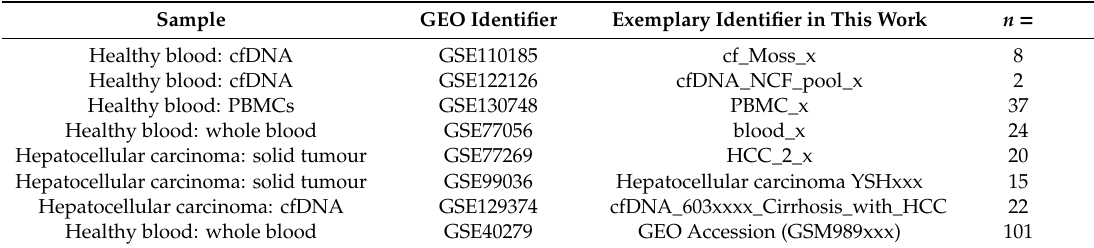
Table 1. Gene Expression Omnibus (GEO) datasets used in this work. cfDNA: cell-free DNA, PBMCs: peripheral blood mononuclear